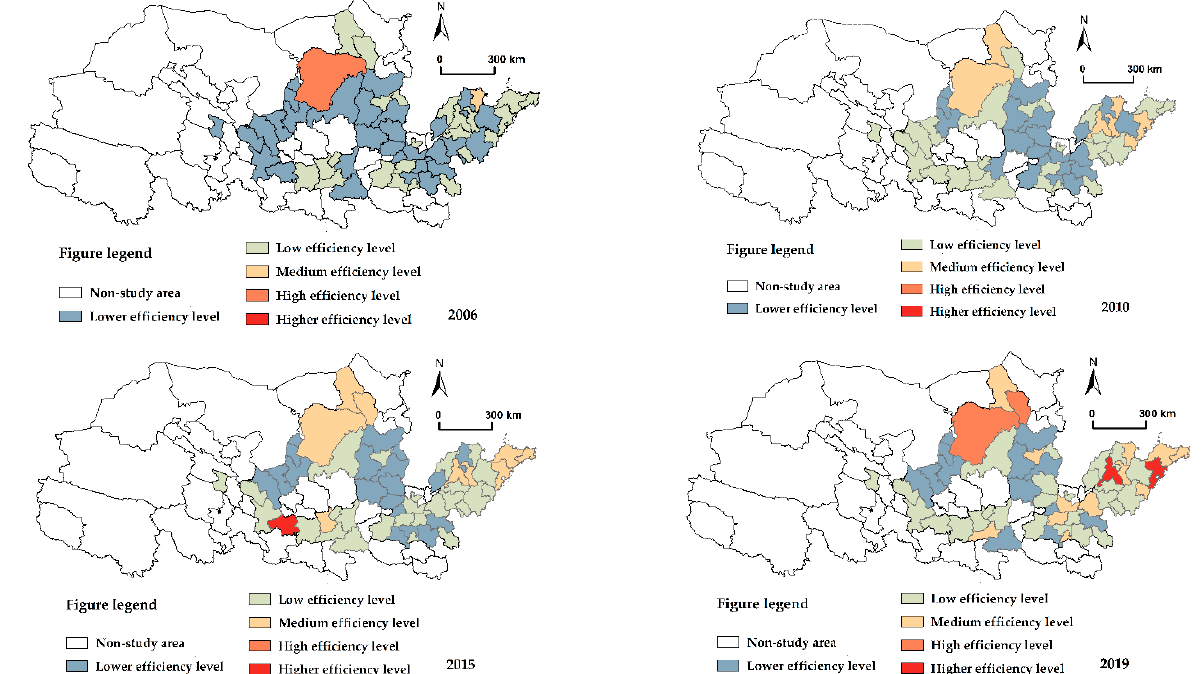
Figure 4. Spatial distribution of carbon emission efficiency in the Yellow River Basin.